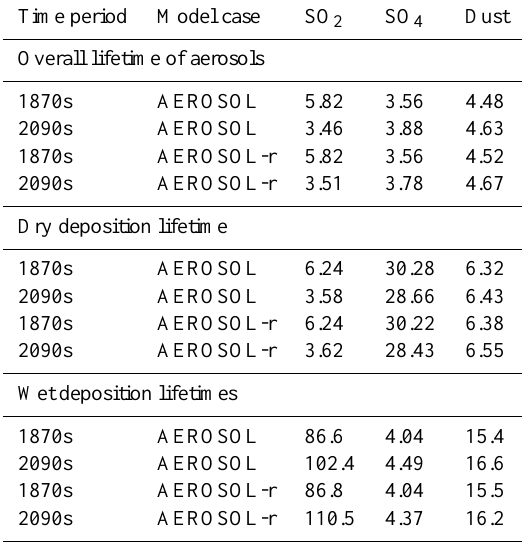
Table 2. Evolution of aerosol lifetime with climate and carbon diox- ide changes